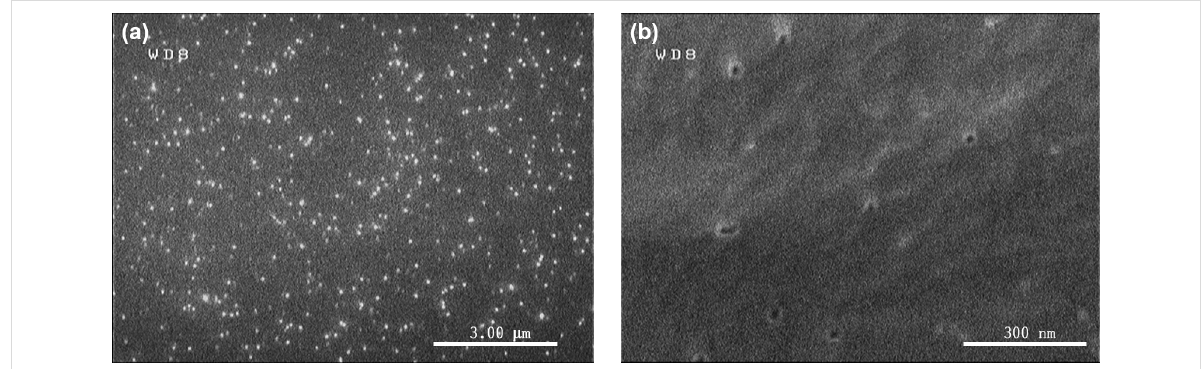
Figure 1: Field emission scanning electron microscope (FESEM) images of the surface of a PCTE membrane employed in our assays. (a) Randomly distributed pores cover the surface. (b) The diameter of the pores is around 30 nm, as indicated by the